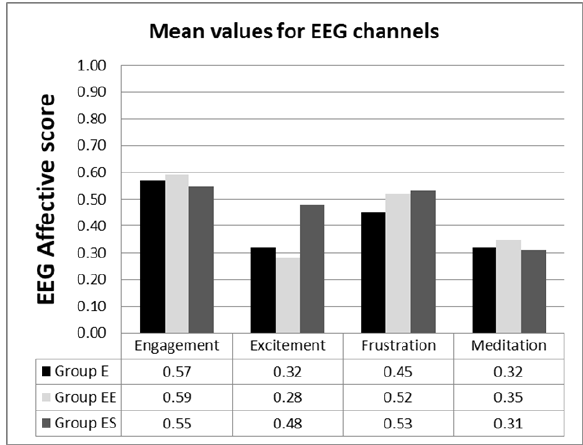
Figure 8. Instructional efficiency for performance and comprehension